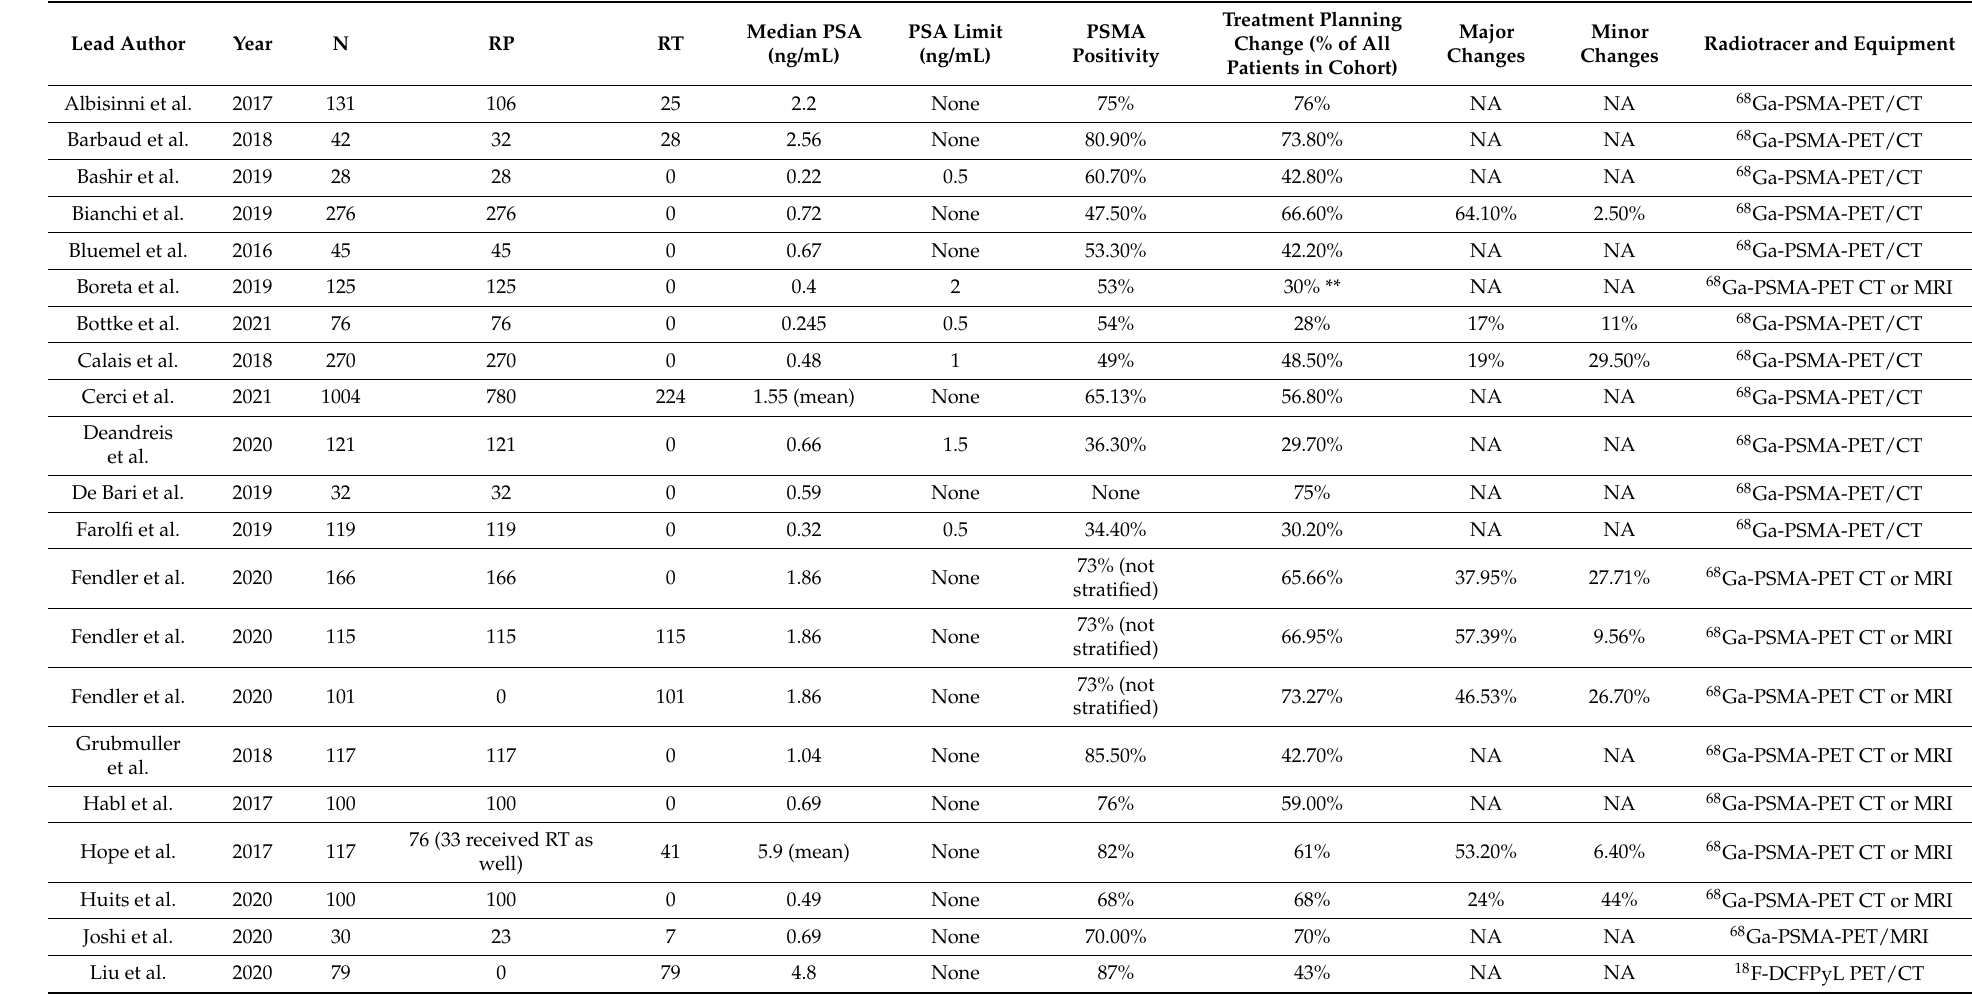
Table 1. Selected studies on the impact of PSMA PET on treatment planning in patients with recurrence after definitive